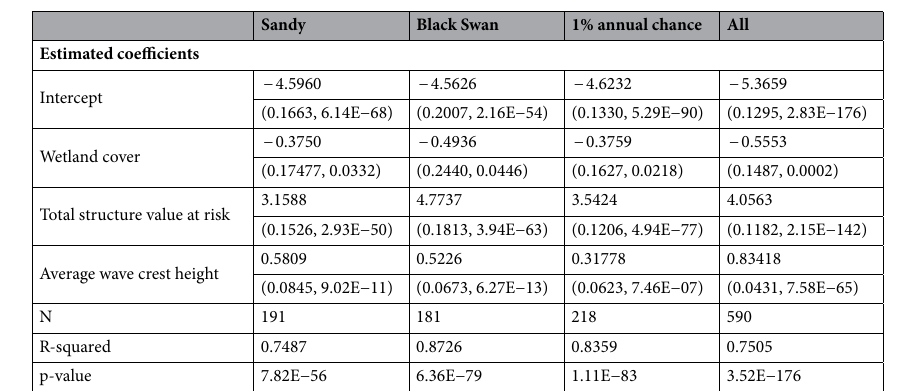
Table 1. Zip-code damage regression model estimates. The first value inside parenthesis represents the standard error and the second value in parenthesis represents p-values.